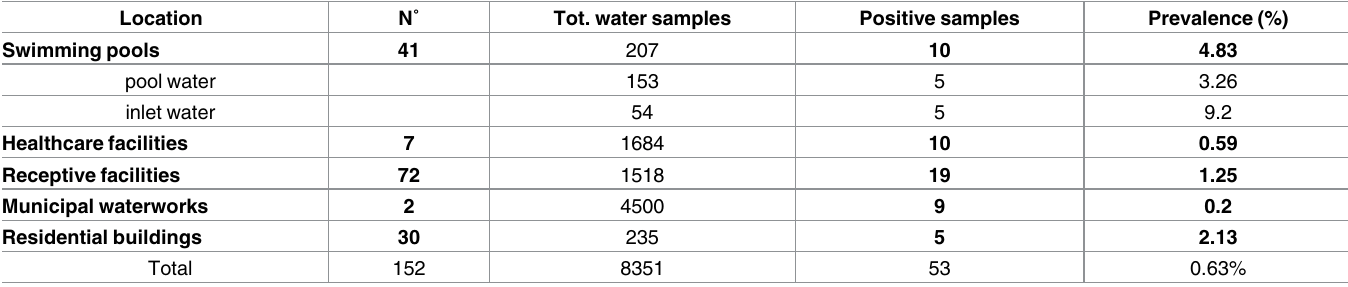
Table 2. Prevalence of Pseudomonas aeruginosa in water samples from different locations. Location N˚ Tot. water